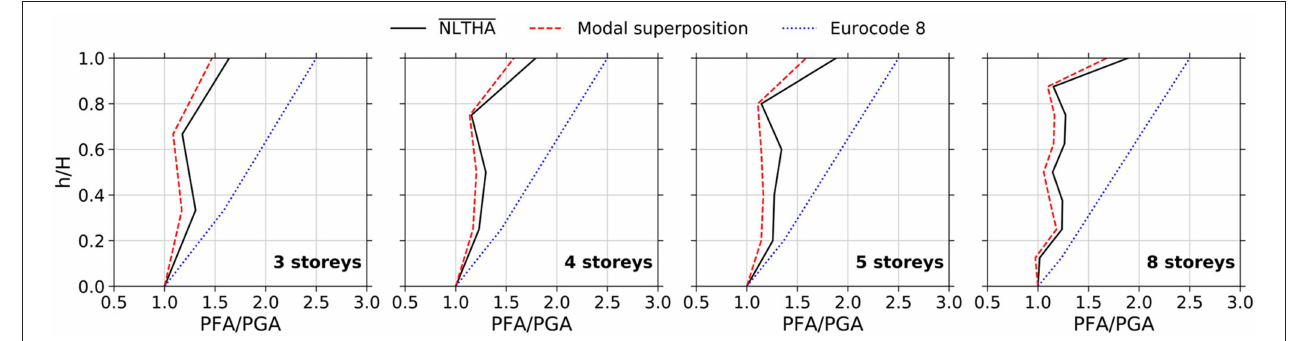
FIGURE 7 | Example of PFA comparisons between mean response-history analyses and estimation procedures (with targeted elastic ductility demands, archetypes of building config. 1).